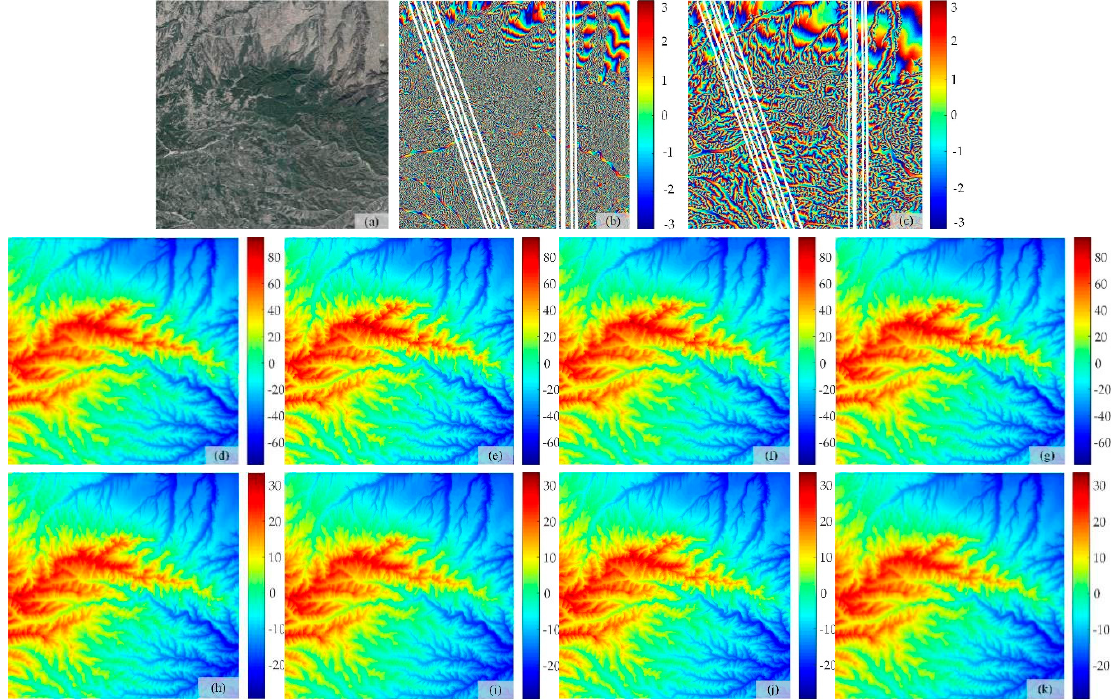
Figure 5. ( a ) Google Earth image of the study area. ( b,c ) Real interferograms with ( b ) long, and ( c ) short baseline lengths. ( d–g ) PU results of ( b ) obtained by ( d ) TSPA, ( e ) TSPAEKF, ( f ) TSPACKF, and